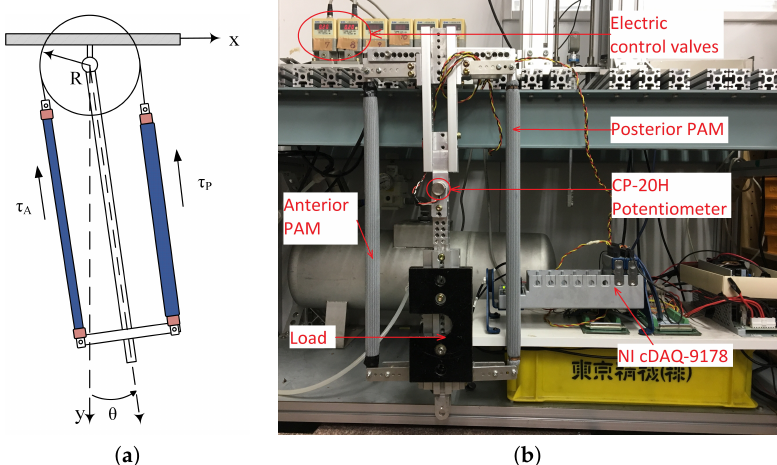
Figure 1. ( a ) Typical antagonistic configuration of two pneumatic artificial muscles (PAMs) and ( b ) experiment platform of an antagonistic actuator powered by